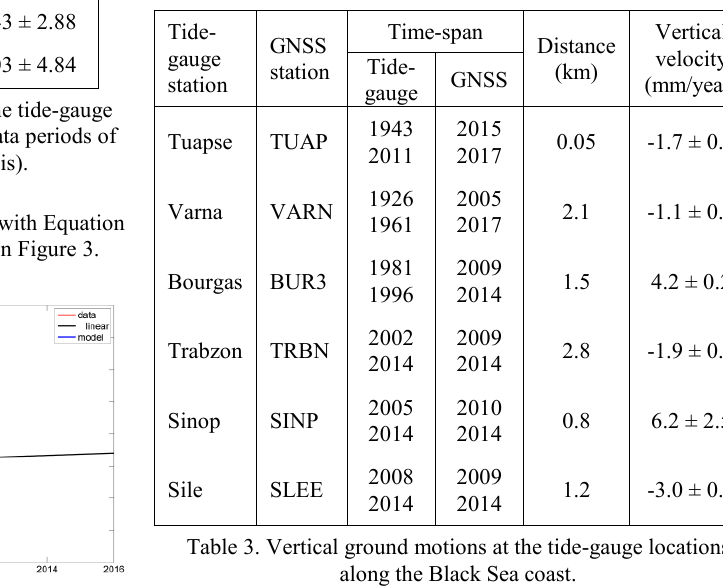
Figure 3. Trend and curve fitting model of ~ 10-year sea level time series at Amasra tide-gauge station.